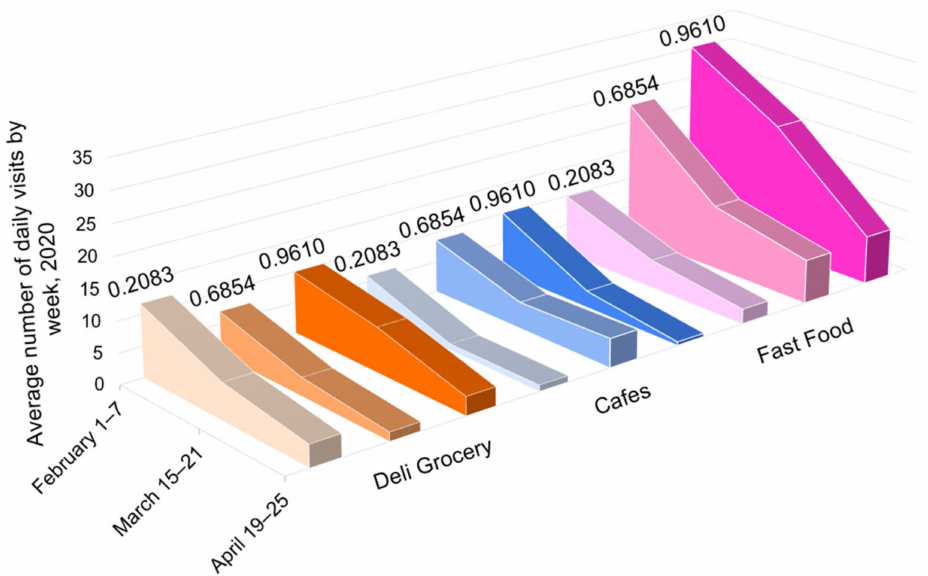
Figure 6. Daily visits per location for food-related POIs for 23rd St CityMD (SVI 0.2083), Wyckoff Heights Medical Center (SVI 0.6854), and Westchester Square CityMD (unweighted SVI 0.9610), based on select cell phone data. Table 4. Percentage change comparing 2020 and 2019 visits per location for food-related POIs